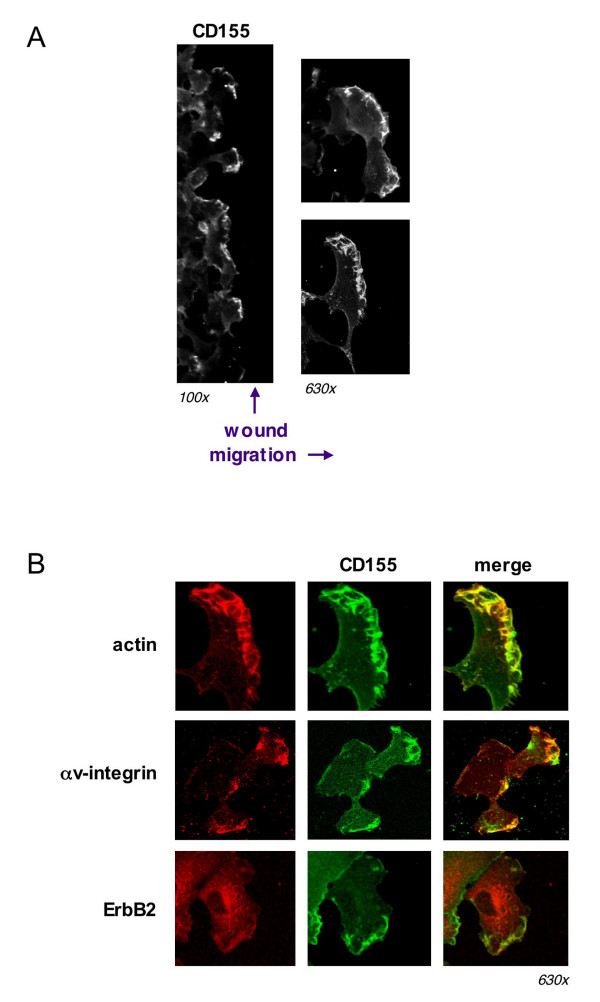
CD155 is recruited to the leading edge of migrating cells and colocalizes with actin and αv-integrin. (a) HT1080 cells were grown to near confluency on a matrigel substrate. A linear wound was made with a 20 g needle and cells allowed to recover for 3 h. Cells were fixed and immunostained for CD155. The majority of CD155 appeared to localize to the leading edge of migrating cells. (b) CD155 colocalized extensively with actin and αv-integrin at the leading edge of HT1080 cells migrating on a matrigel substrate. CD155 did not appear to colocalize with the growth-factor receptor ErbB2.